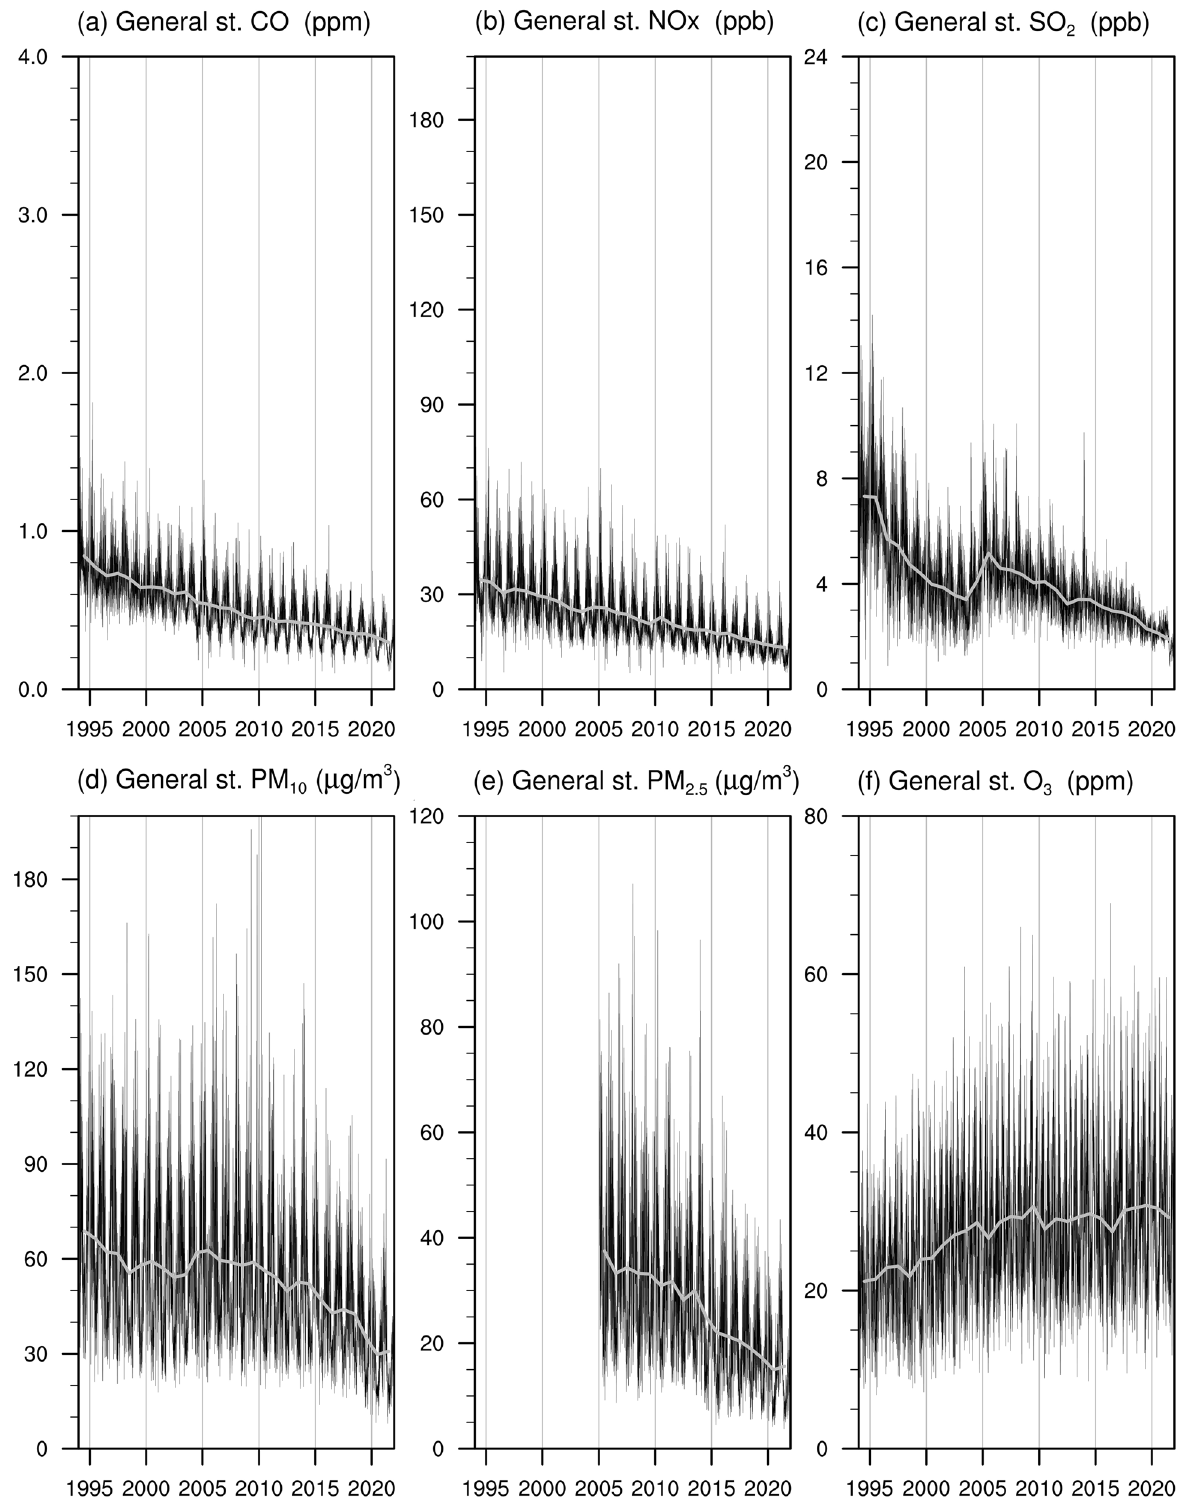
Fig. 2 Variations of daily ( a) CO, ( b) NO x , ( c) SO 2 , ( d) PM 10 , ( e) PM 2.5 , ( f) O 3 concentration (black line) monitored by the general stations with annual mean value for each year (gray